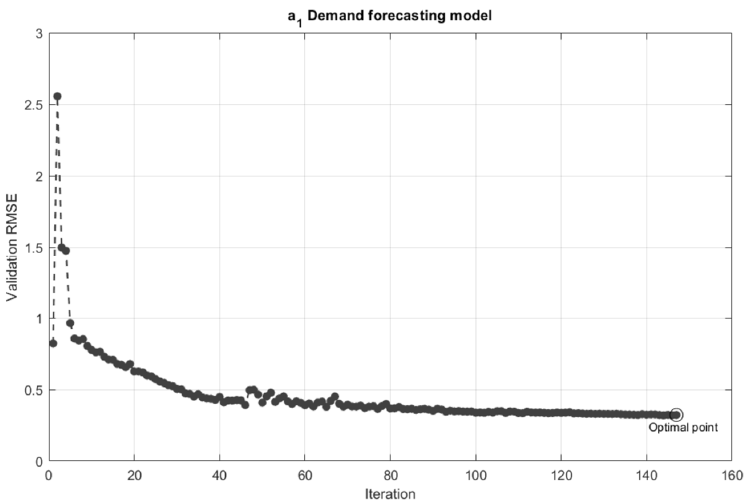
Figure 5. Minimizing validation RMSE of the d 1 forecasting model.